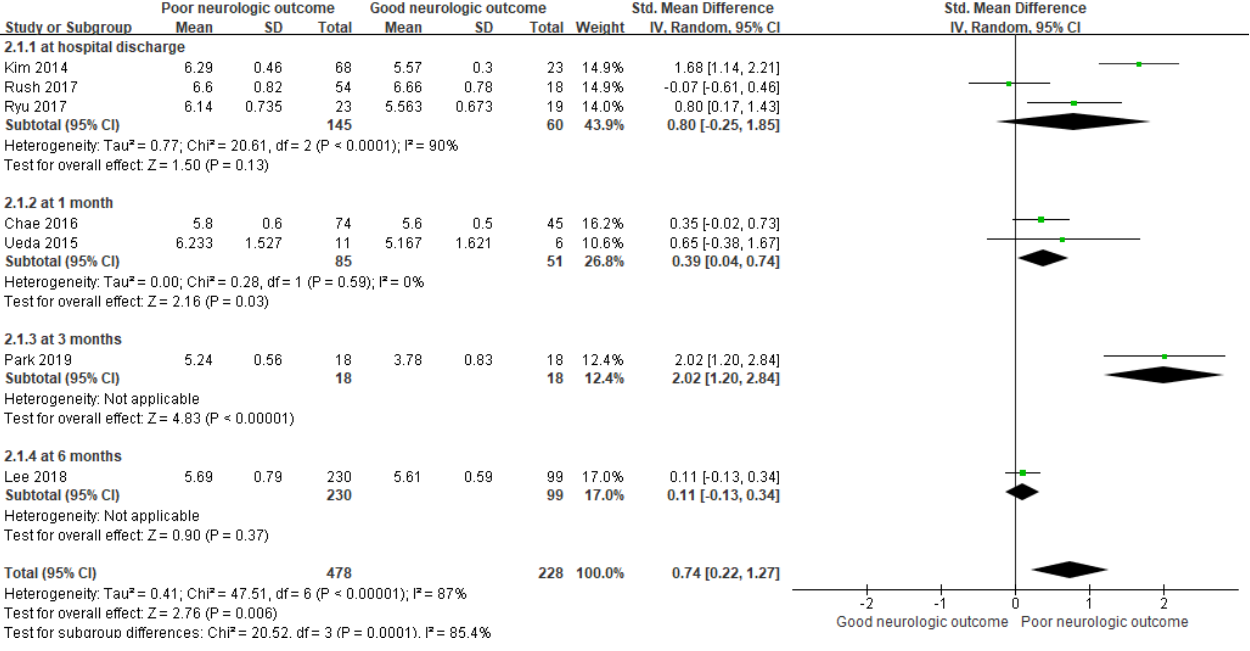
Figure 3. Forest plot for the association of ONSD with death. Abbreviations: CI = confidence inter- val; ONSD = optic nerve sheath diameter; SD = standard deviation.